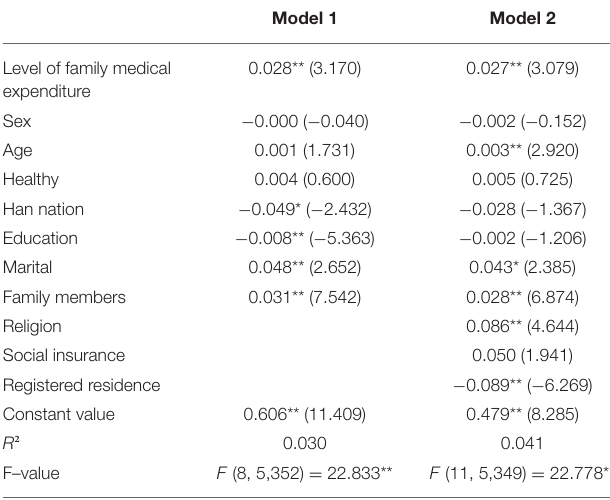
TABLE 5 | Robust standard error regression